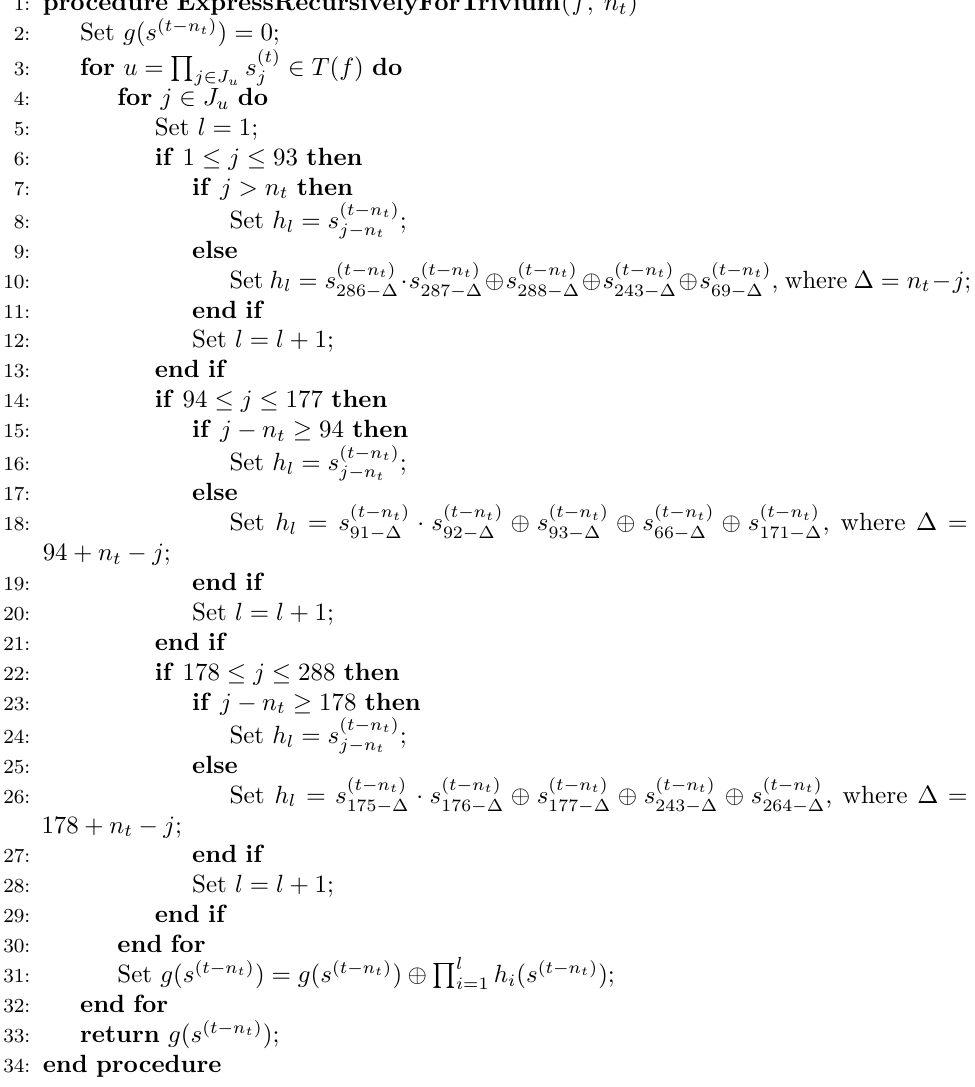
Algorithm 6 Express the polynomial with earlier internal